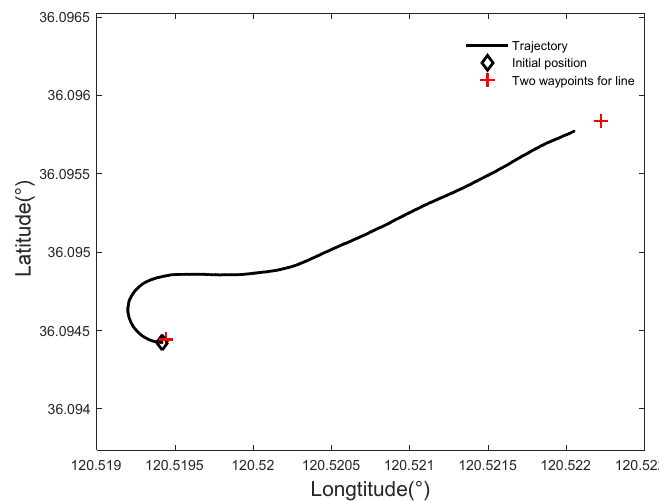
Figure 14. Line tracking by the USV in the sea experiment.